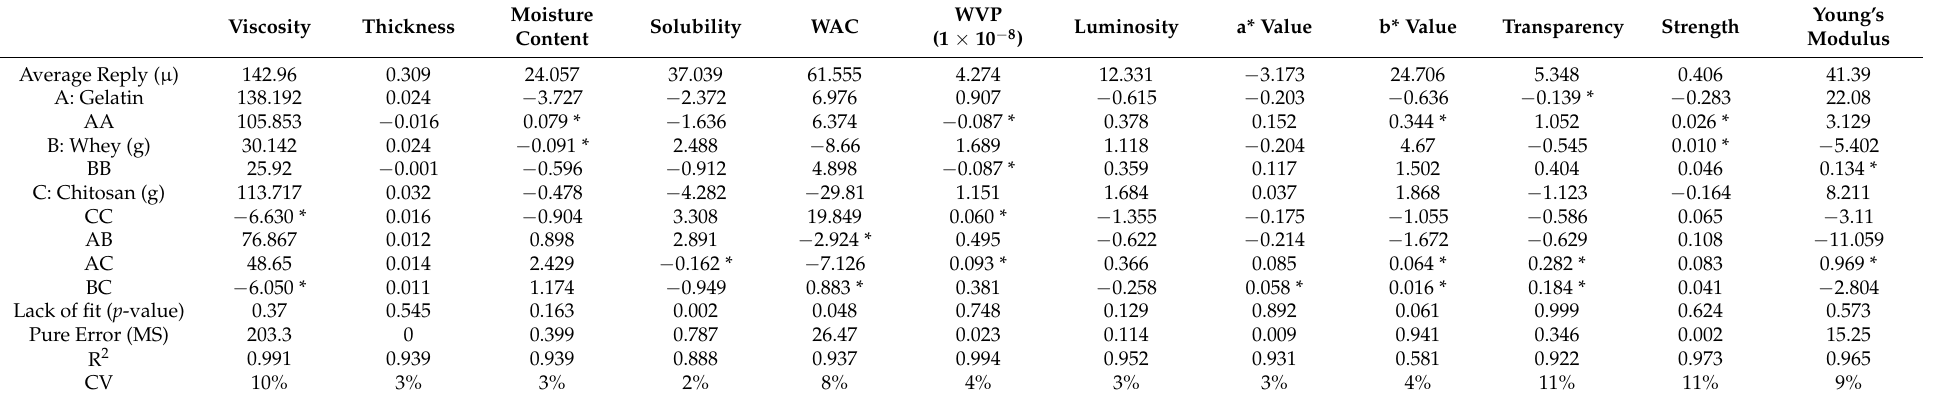
Young’s Transparency Strength